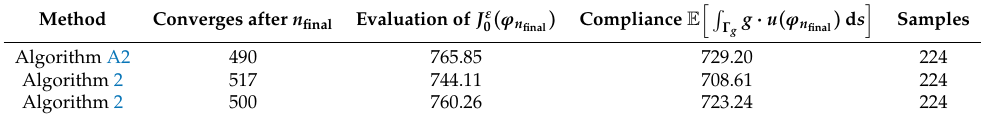
Table 2. Comparison of metrics between Algorithms A2 and 2.